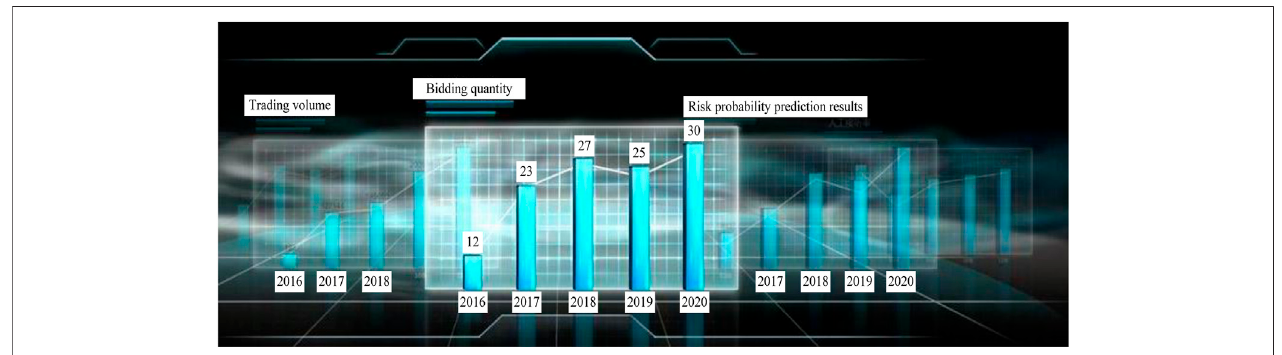
FIGURE 4 | Control result visualisation